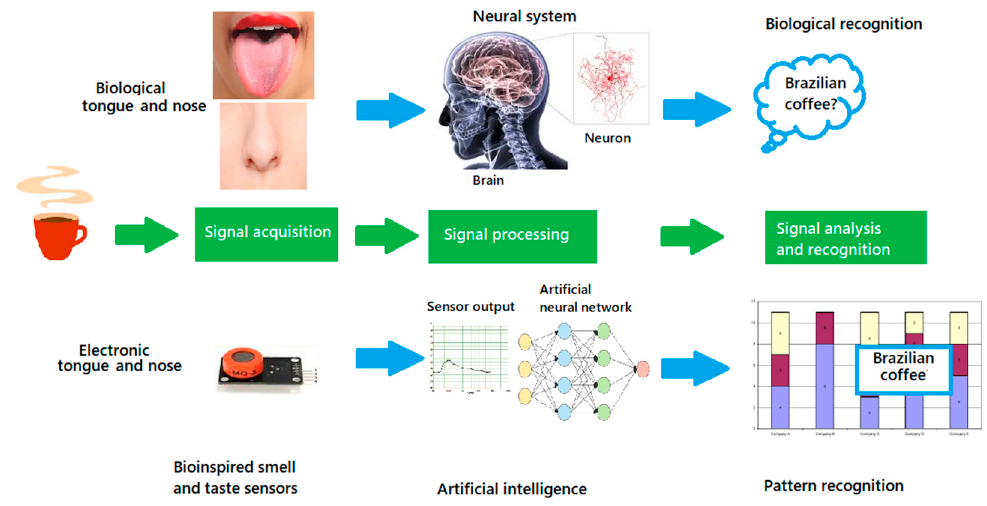
Figure 9. A schematic diagram illustrating E-nose and E-tongue in comparison with biological nose and tongue (Adopted from Wang et al. [132] ).